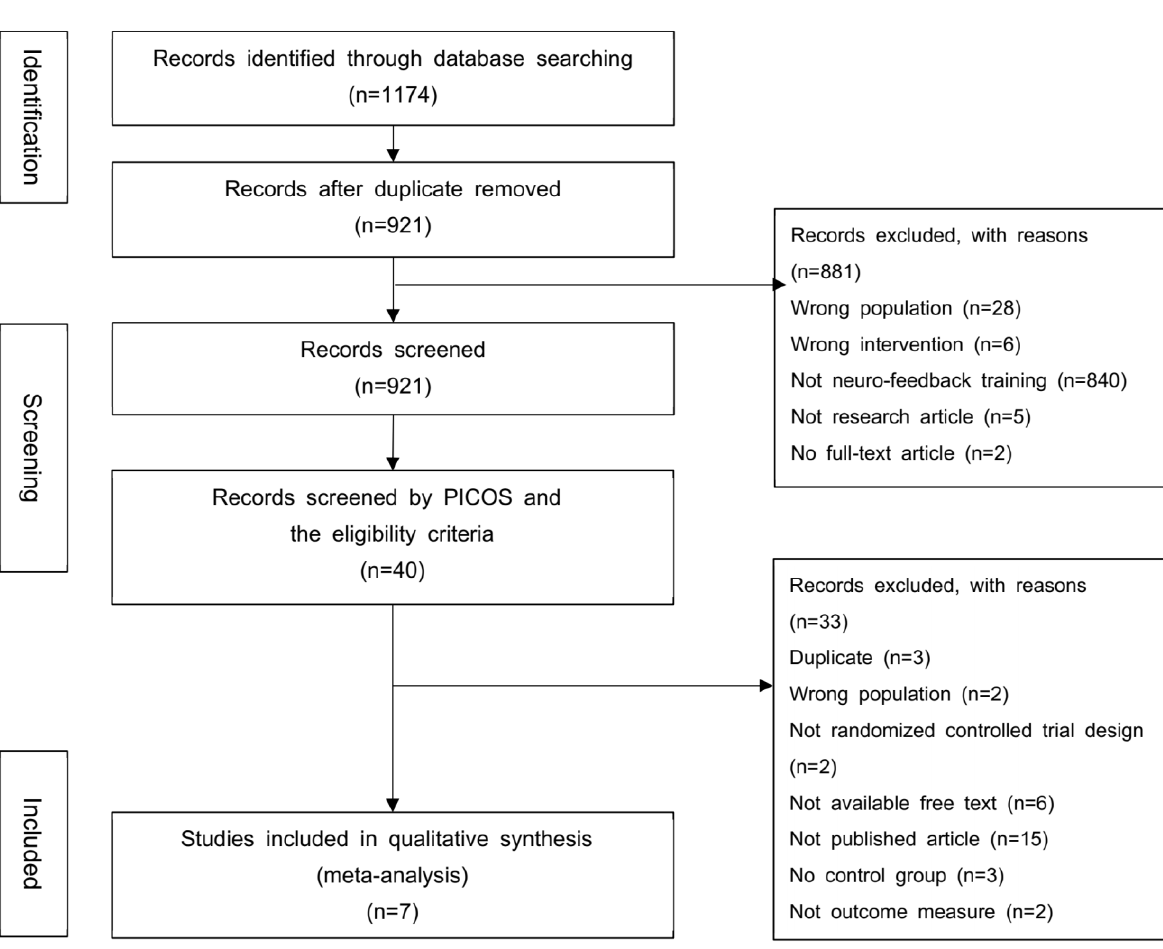
Figure 1. Flowchart of studies included in the meta-analysis.